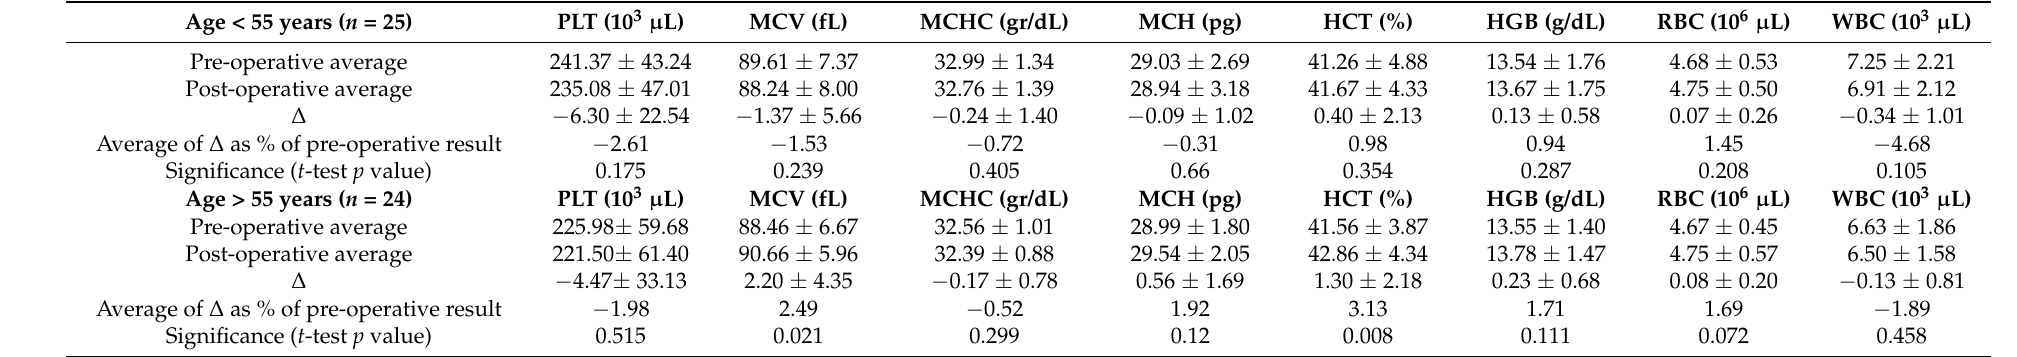
Table 2. Change between pre-operative and post-operative CBC parameters stratified by